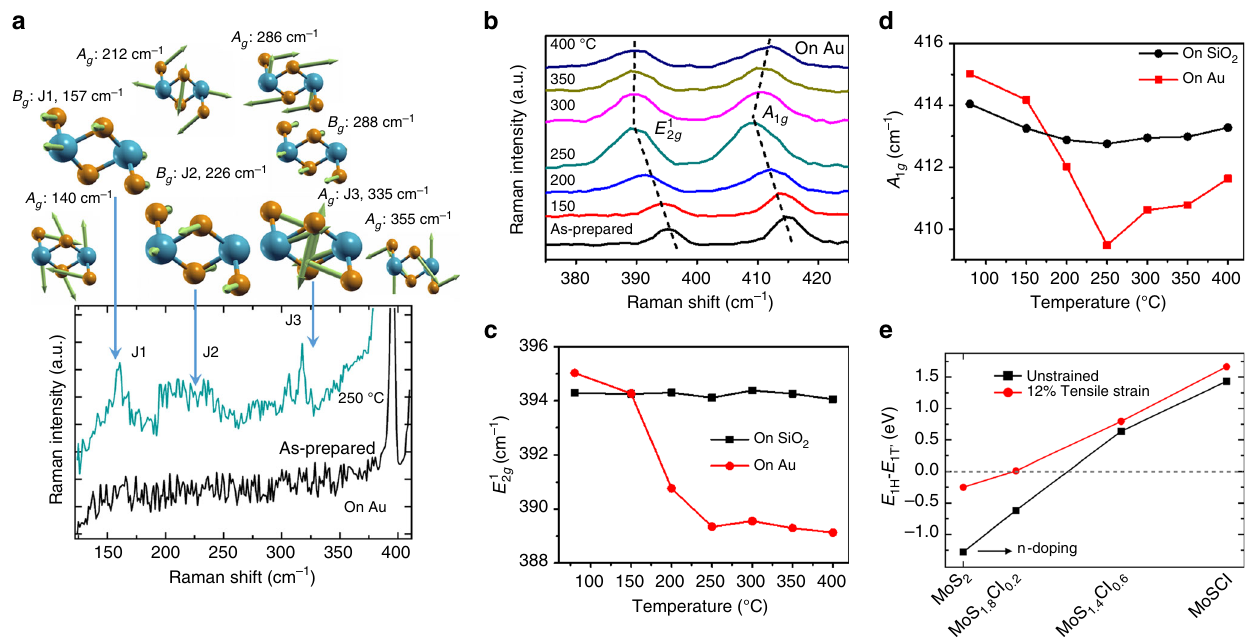
Fig. 4 Annealing temperature dependence of Raman spectroscopy. a ( top ) Calculated Raman active eigenmodes and frequencies, with corresponding irreducible representation assigned from group theory. a ( bottom ) Comparison of Raman spectra of MoS 2 /Au before and after annealing at 250 °C. b Raman spectra of MoS 2 fi lm on Au electrode in the device (Fig. 2b) at various temperatures. c , d Extracted frequencies of E 1 of temperature. The errors of the extracted energy positions are 0.5 cm − 1 . e Calculated energy difference between 1H and 1T ’ phases as a function